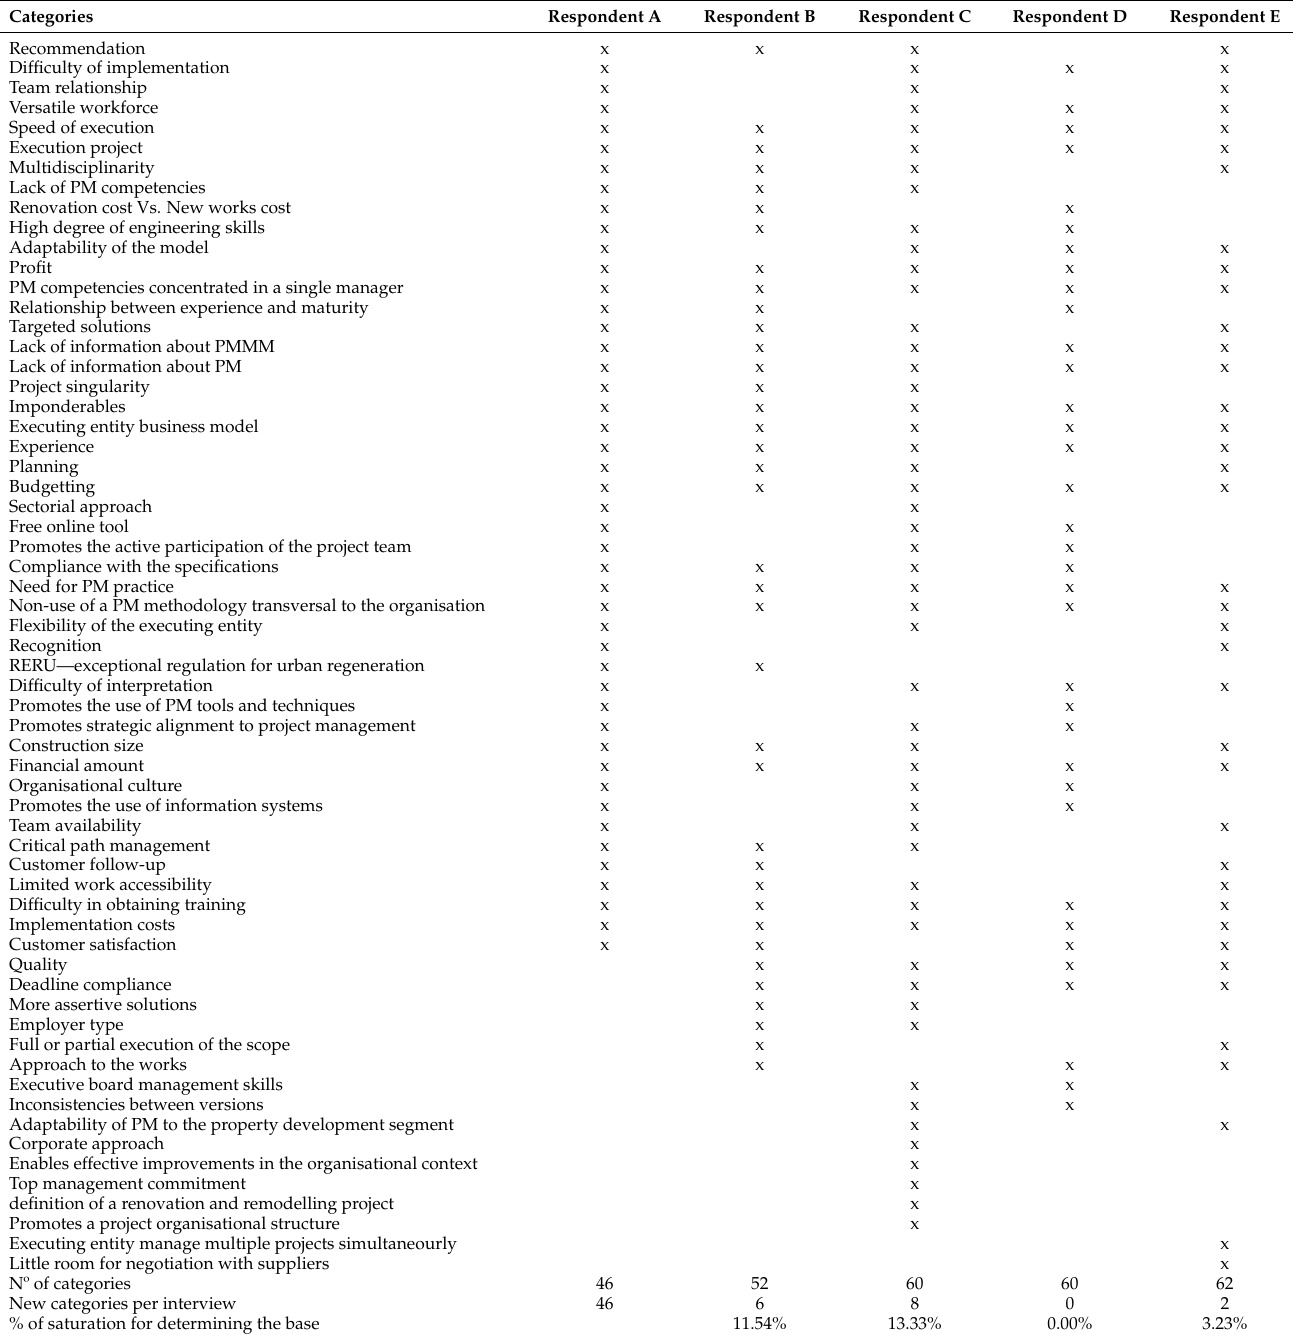
Table A5. Saturation